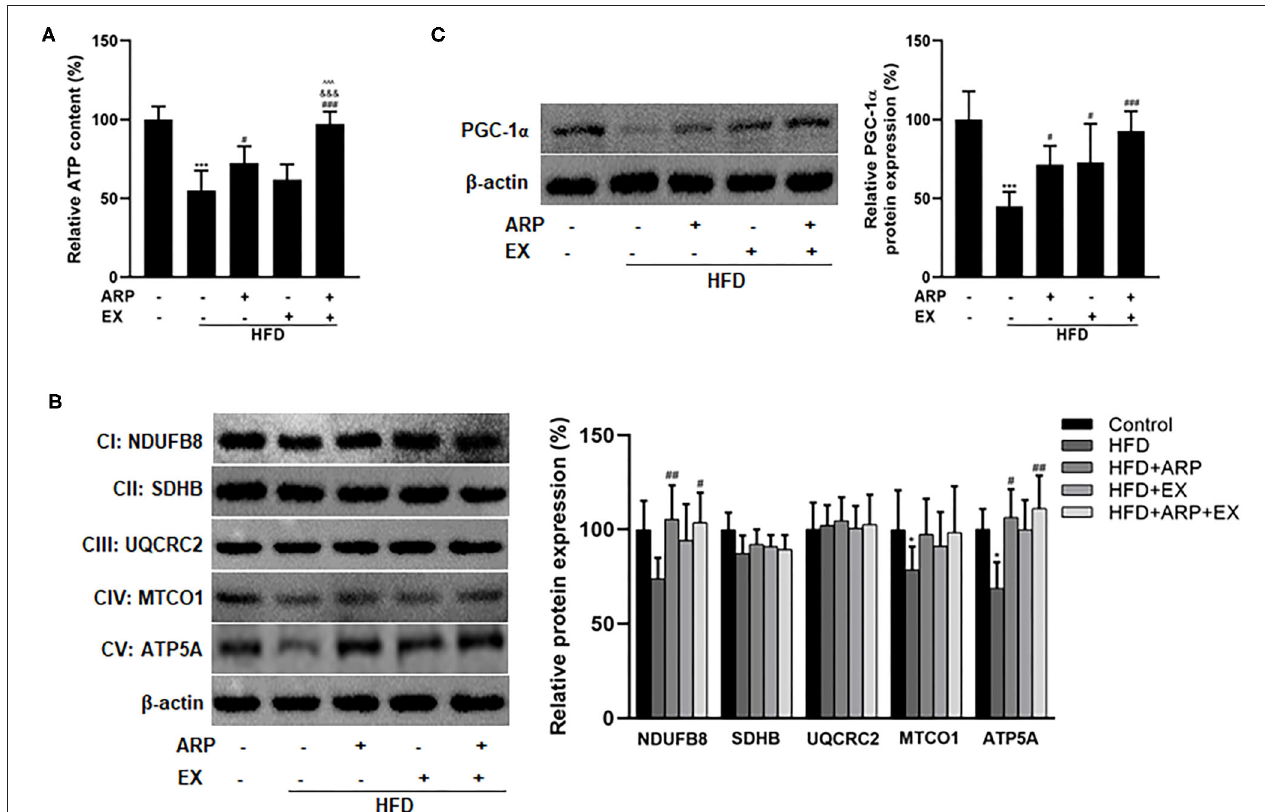
FIGURE 6 | Effects of ARP and EX mitochondrial biogenesis in HFD-fed mice. (A) Liver ATP content. Liver expression of PGC-1 α (B) and mitochondrial complexes subunits (C) (left, western blot image; right, statistical analysis). All the values are exhibited as mean ± SME, n = 8. * p < 0.05 and *** p < 0.001 vs. related control group; # p < 0.05, ## p < 0.01, and ### p < 0.001 vs. related HFD group; ∧∧∧ p < 0.001 vs. related HFD + AR group; &&& p < 0.001 vs. related HFD + EX